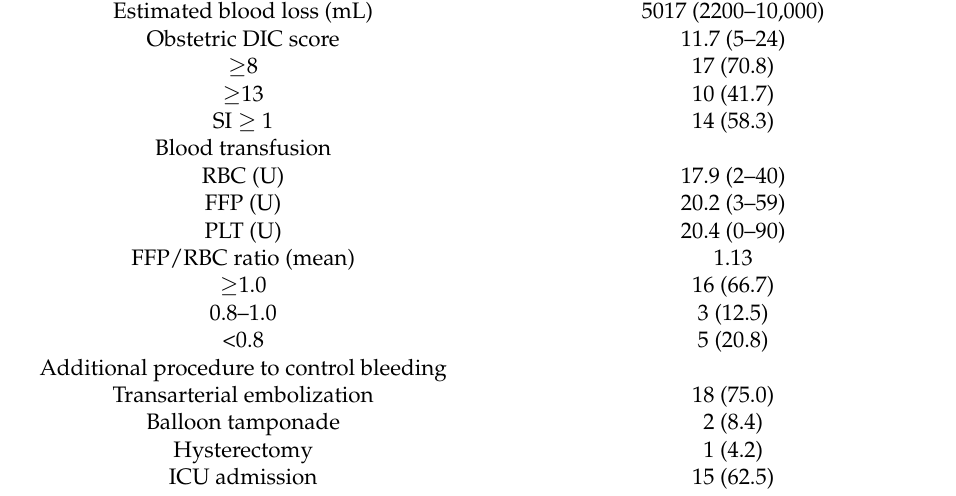
Table 2. Intrapartum